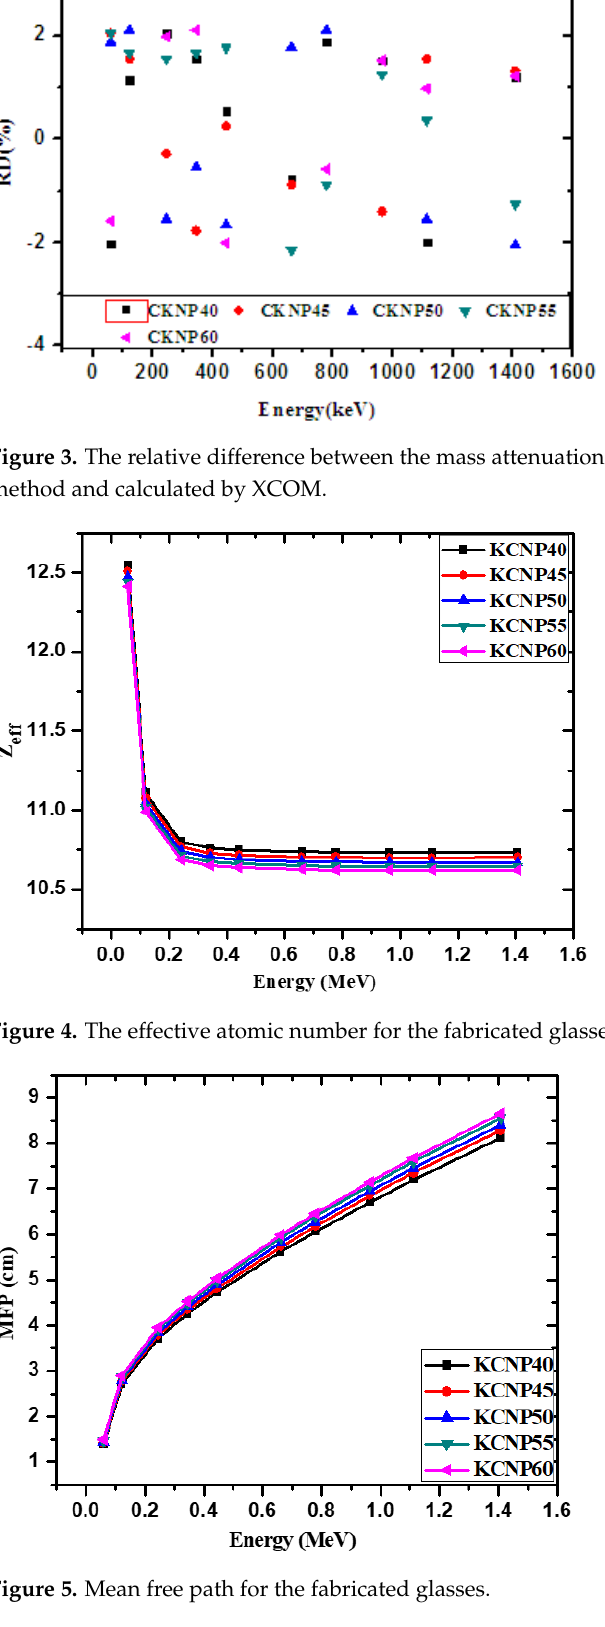
Figure 3. The relative difference between the mass attenuation coefficient obtained by experimental method and calculated by XCOM.